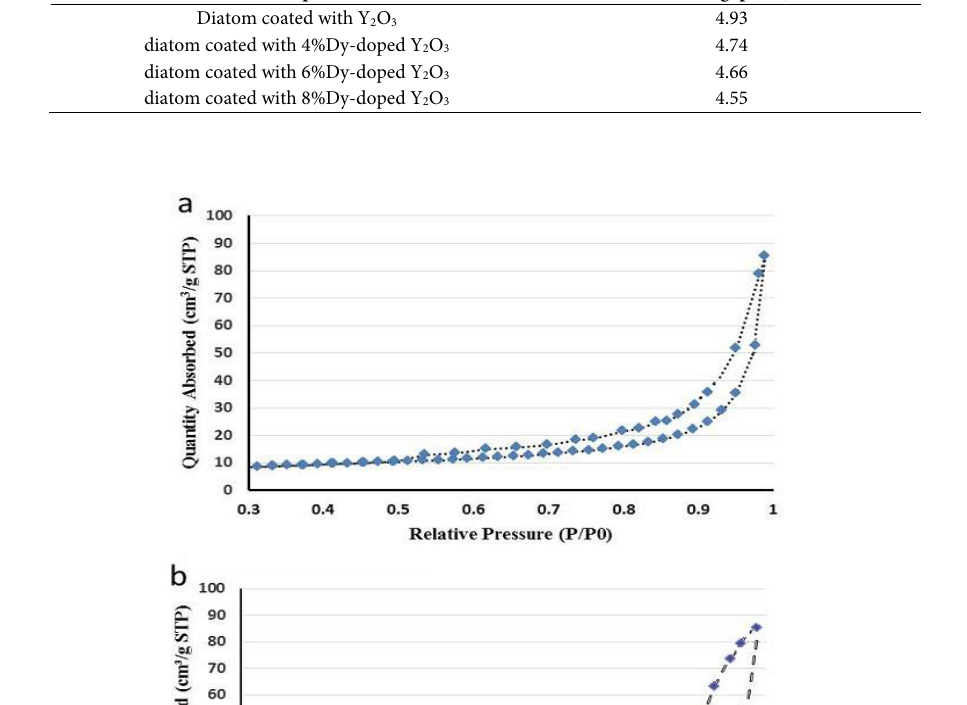
Figure 5. Adsorption – desorption isotherm of nitrogen for diatomite (a) and diatom coated with 6% Dy-doped Y 2 O 3 (b)